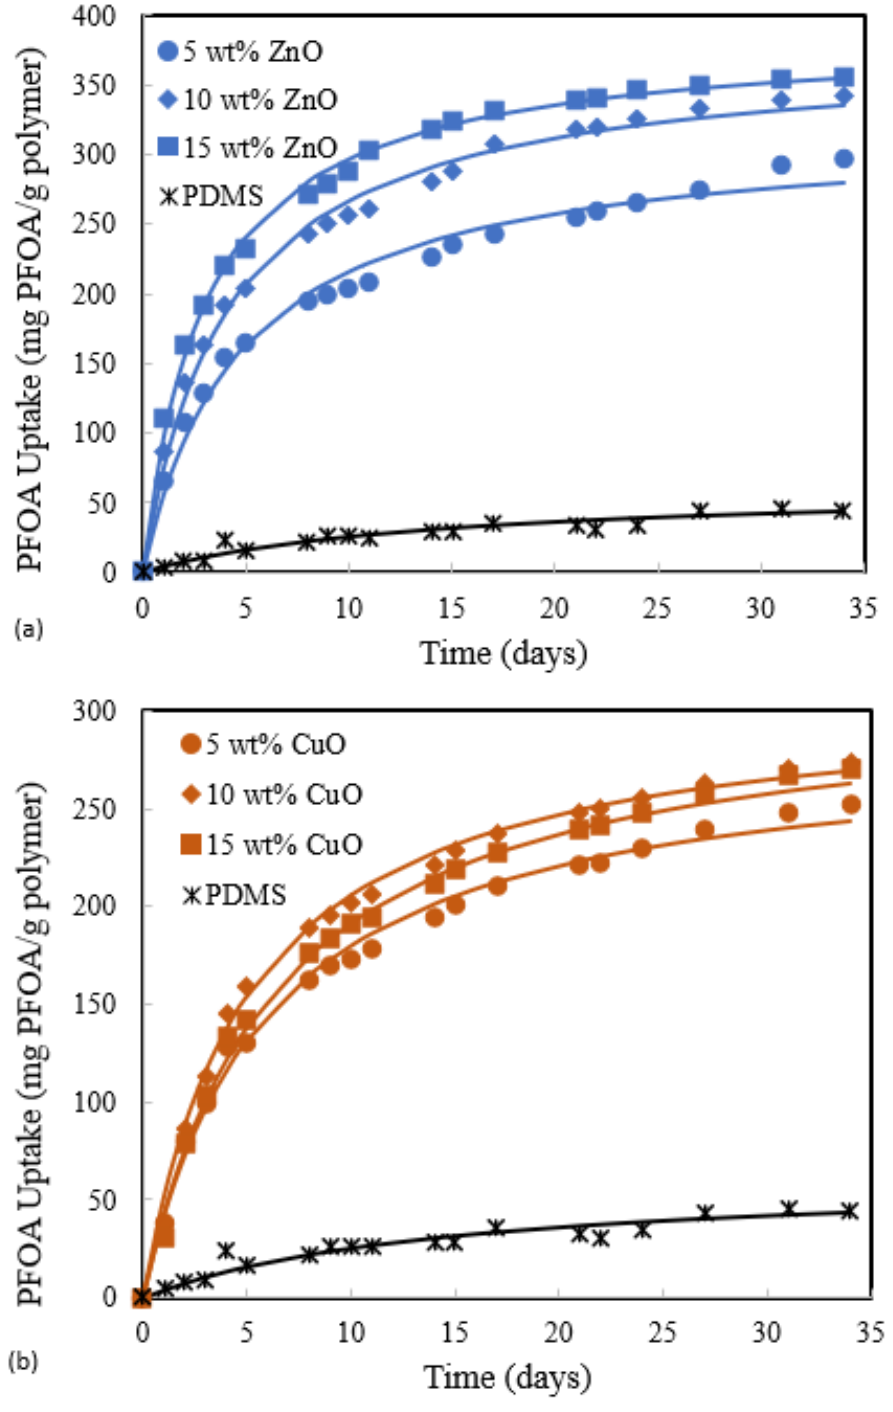
Figure 5. Effect of particle loading in PDMS on PFOA absorption. ( a ) ZnO. ( b ) CuO. The second-order kinetic adsorption model (Equation (6)) was fit to the experimental data in Figures 4 – 6. The second-order kinetic constant, k 2 , and the equilibrium constant, q e , were model parameters that were varied to fit the experimental data to the model. The